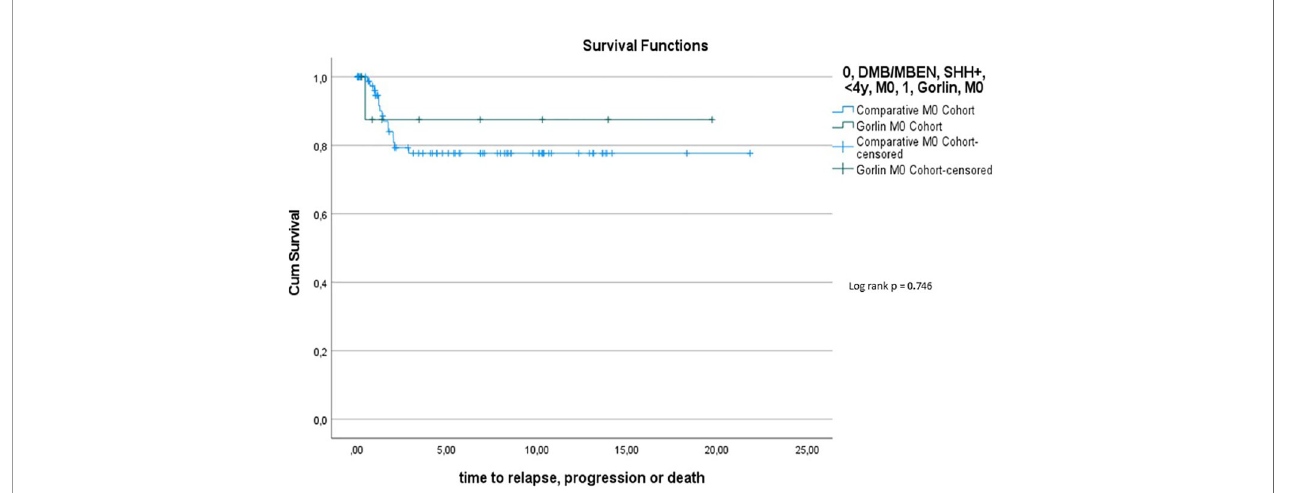
FIGURE 11 | Comparison of PFS (Gorlin M0 cohort vs . Comparative M0